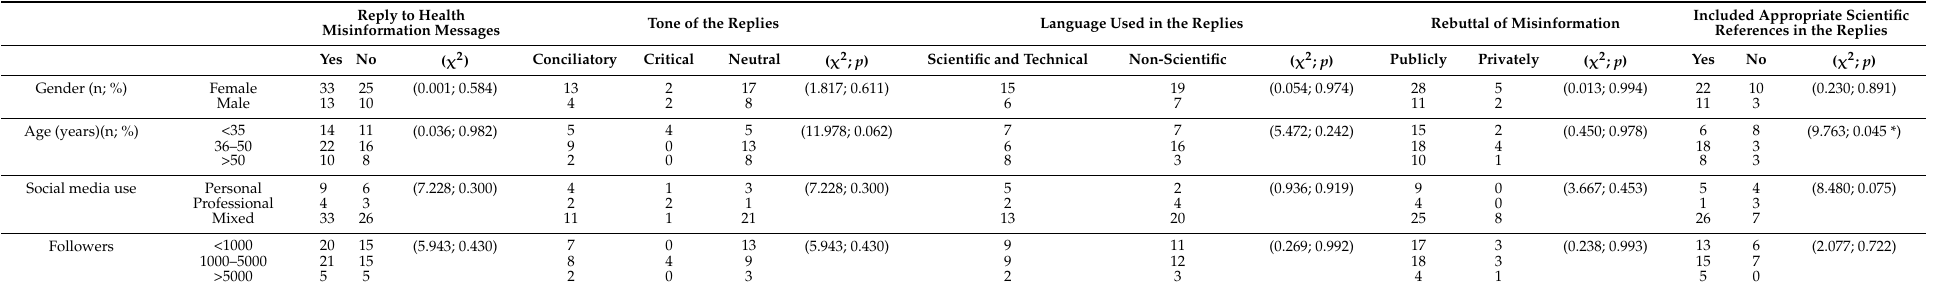
Table 3. Influence of sociodemographic characteristics on how users reply to health misinformation messages. ReplytoHealth MisinformationMessages